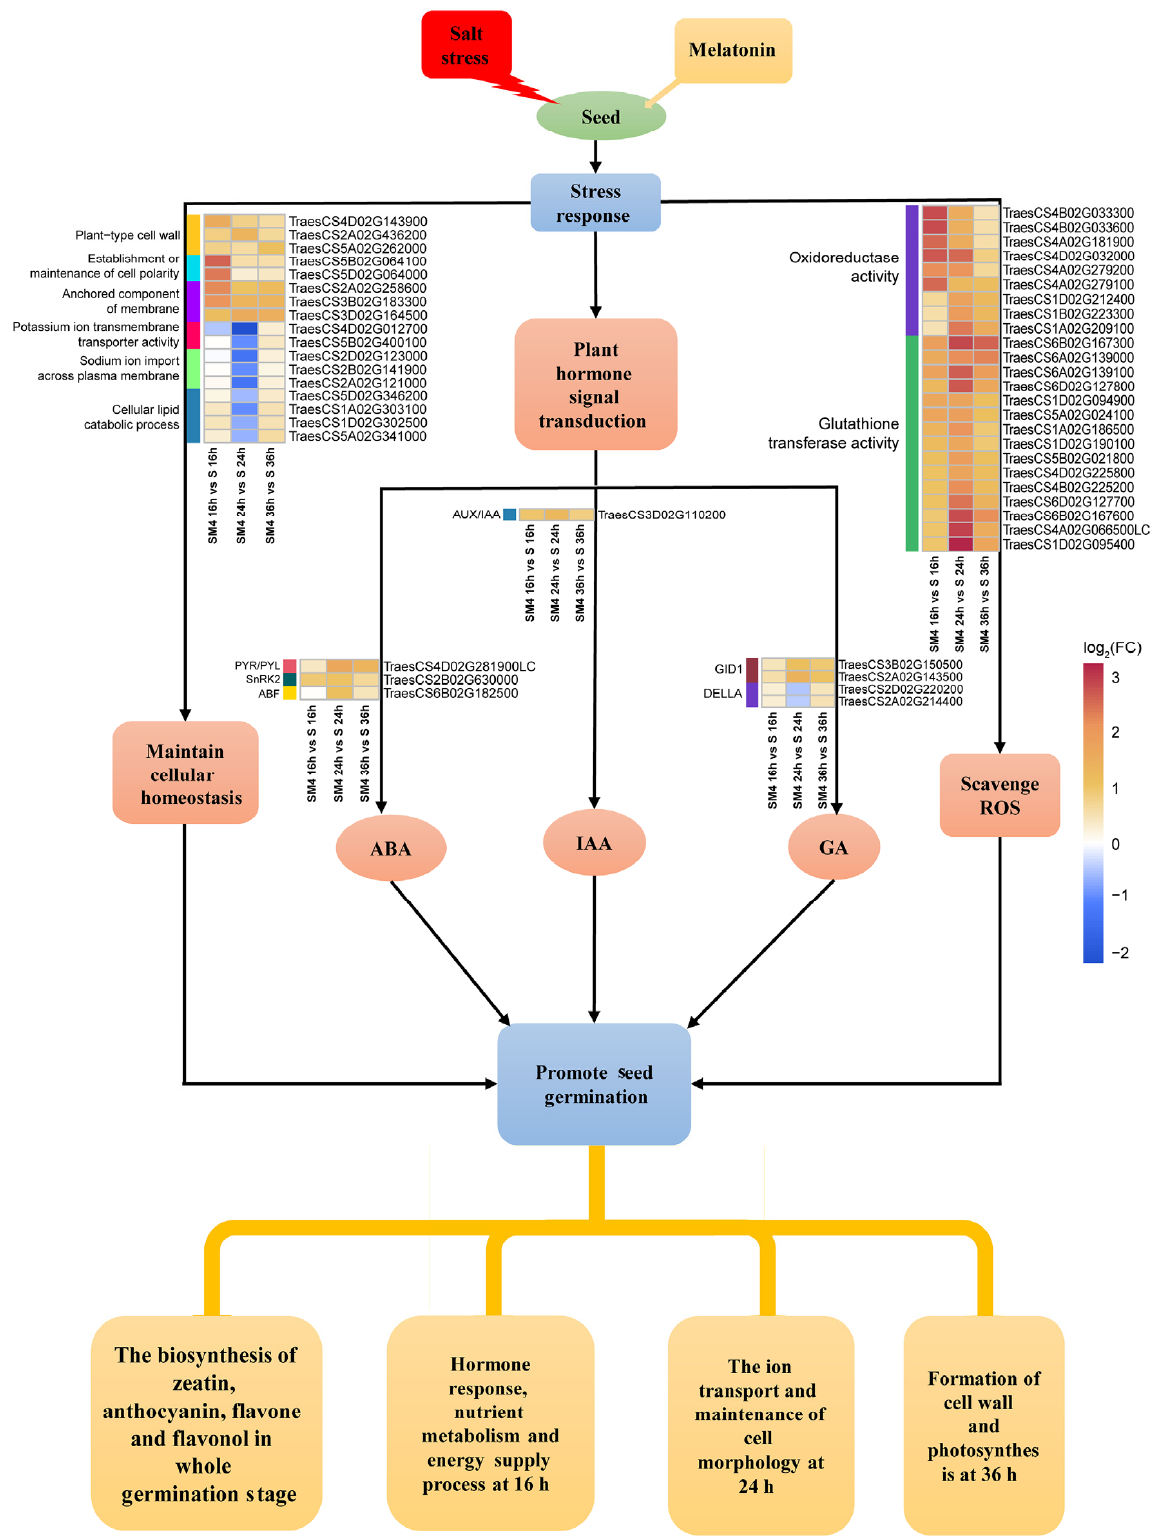
Figure 6. Schematic diagram of a model for MT to promote seed germination. MT maintained the cellular homeostasis of seeds, scavenged ROS, and improved the salt tolerance of seeds through the co-regulation of hormones signal transduction, flavonol biosynthesis, and antioxidant systems.